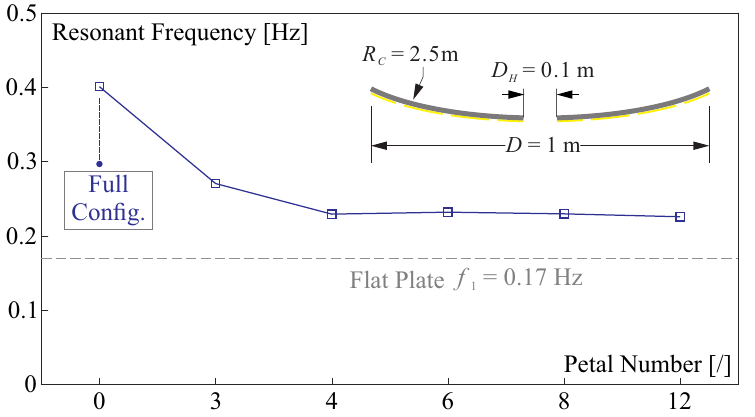
Figure 10. Resonant frequencies of a curved thin shell with respect to the petal